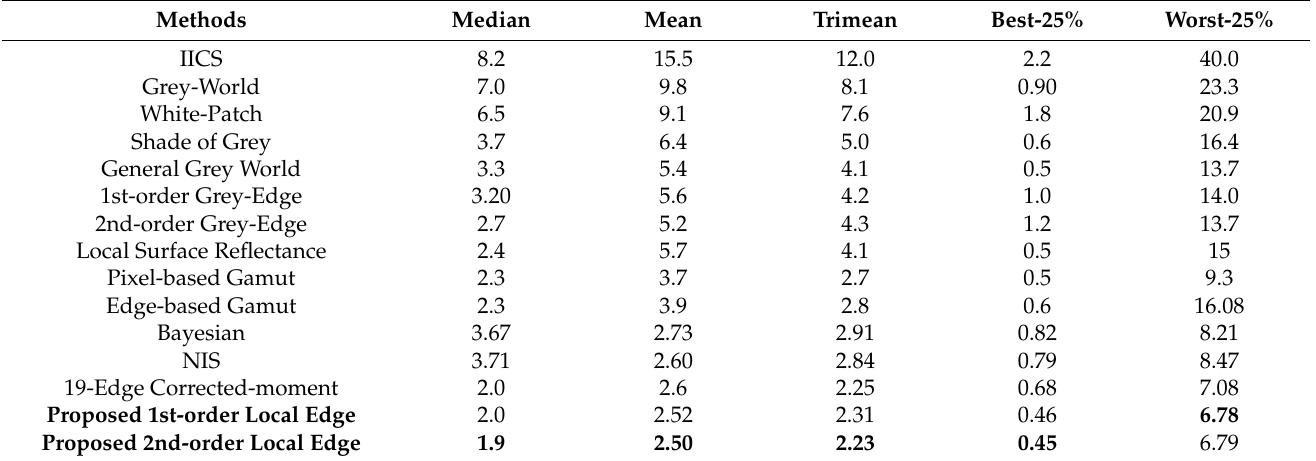
Table 3. The performance of different color constancy methods on the SFU indoor